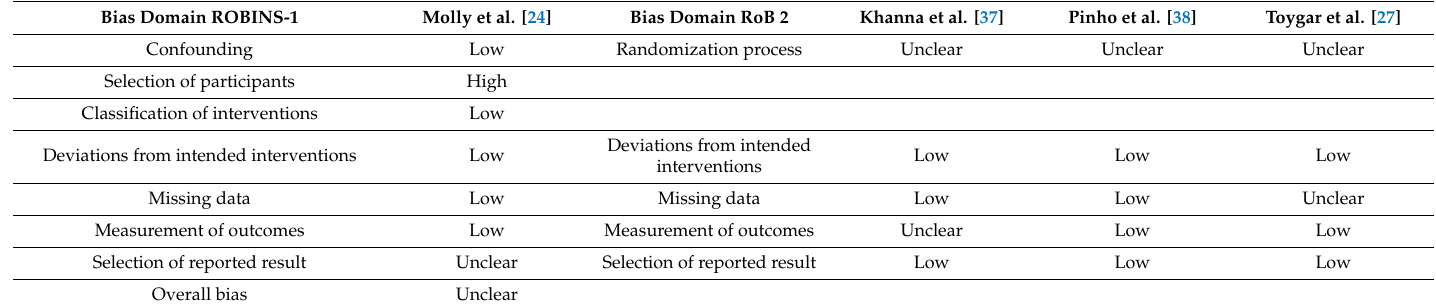
Table 2. Risk of bias across randomized clinical trials and the cohort